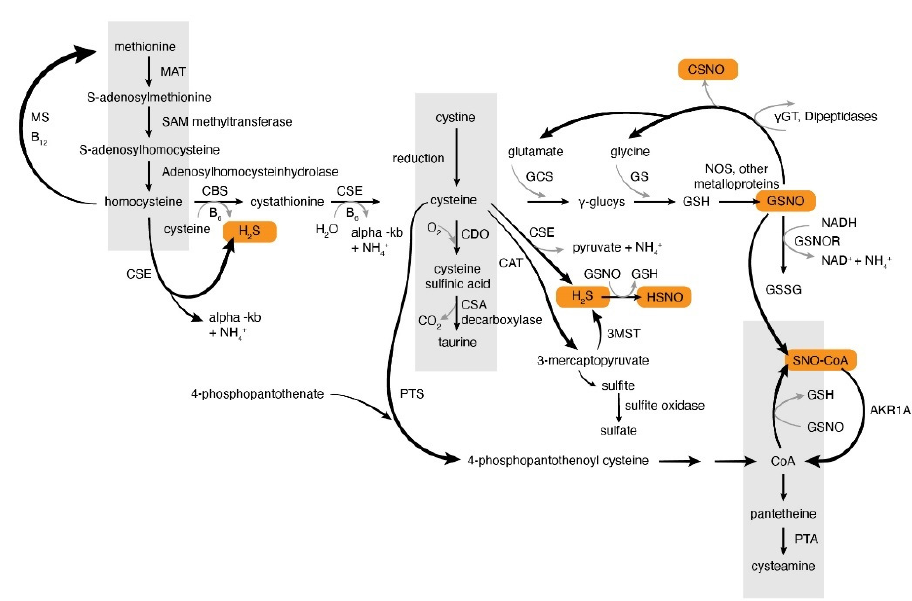
Figure 1. Eukaryotic thiol chemistry and the generation of thiol-based signaling molecules. Orange highlight shows product signaling molecules. AKR1A1—aldoketoreductase family 1 member 1A,